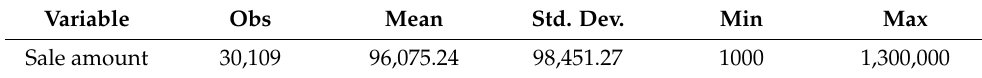
Table 2. The overall situation of the effective house observations data.